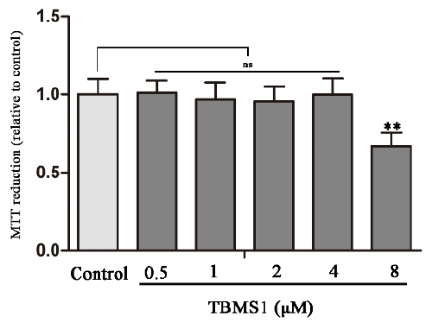
Figure 4. Effect of TBMS1 on the viability of BV-2 cells. The BV-2 cells were incubated for 24 h with